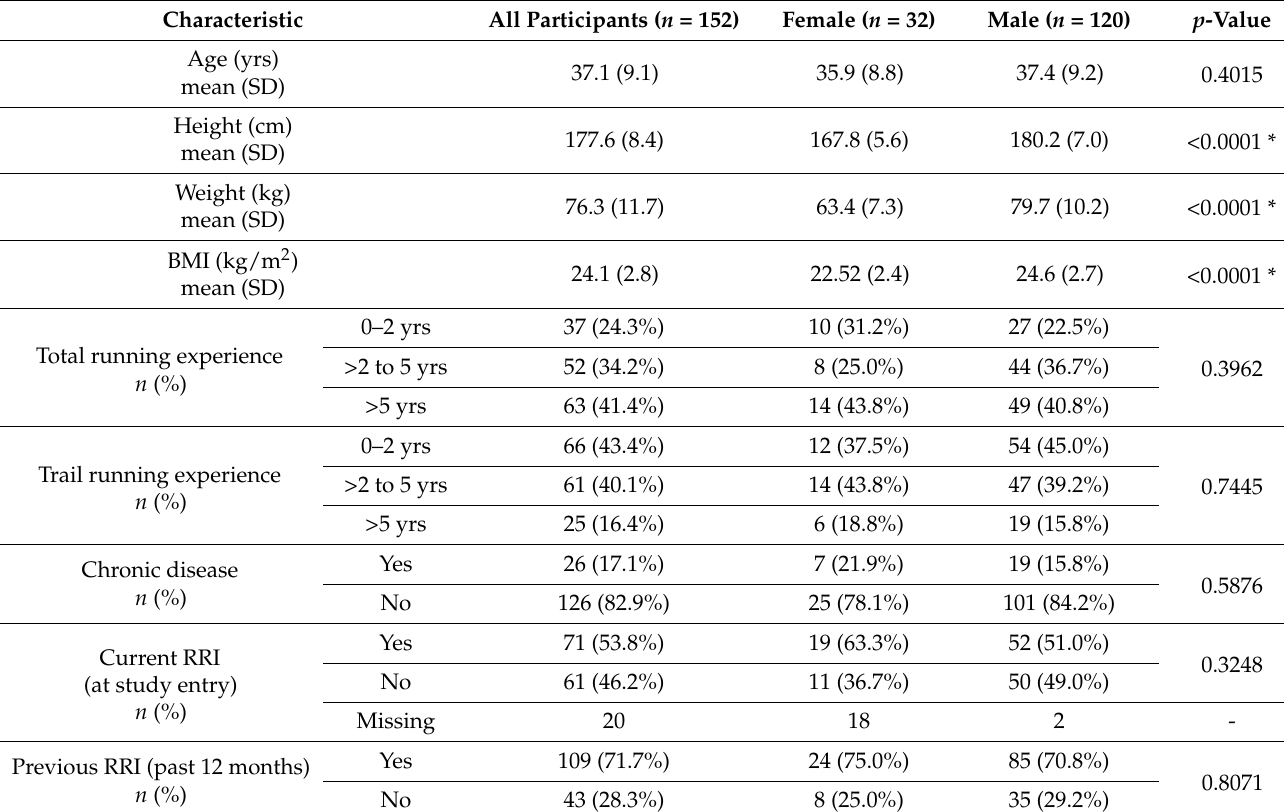
Table 1. Baseline data (demographic profile, running experience, medical history, and RRI history) of all study participants ( n =